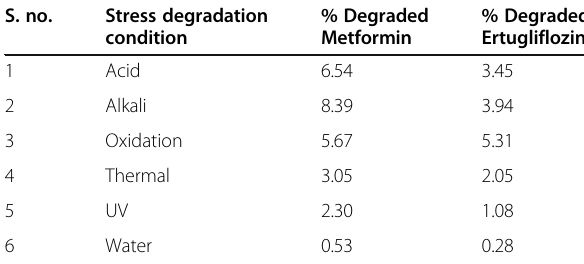
Table 5 Robustness method of Metformin and Ertugliflozin Sr. no Varying conditions